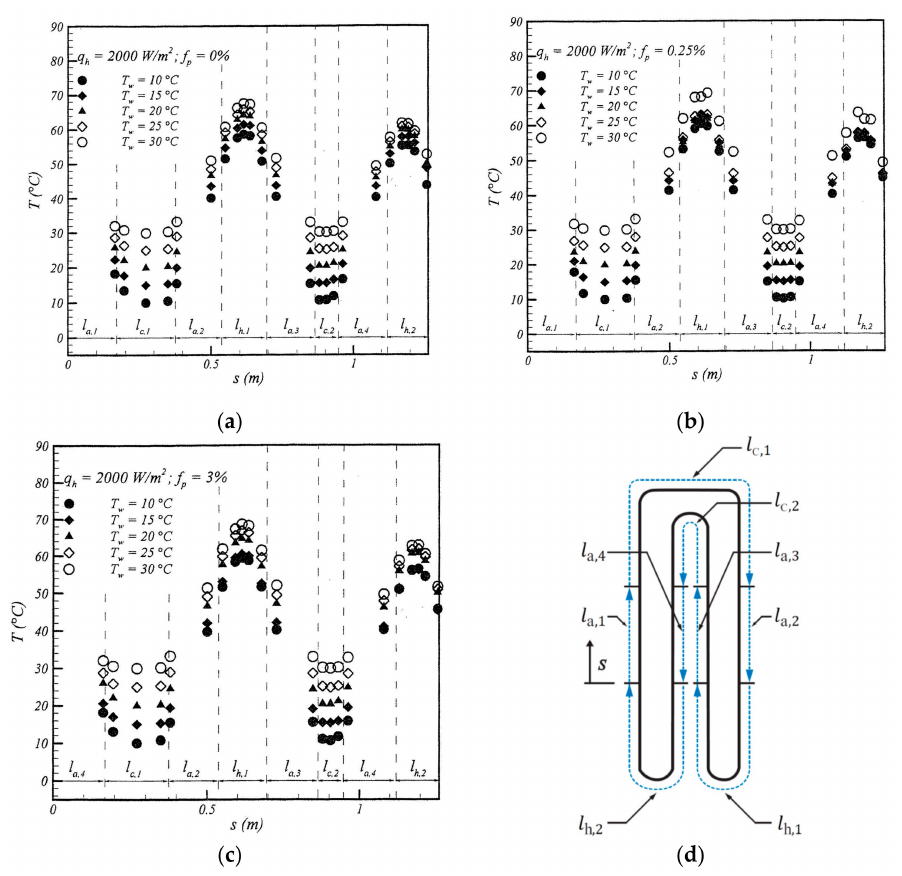
Figure 7. Steady-state temperature distributions of the fluid under different T w value ( q h = 2000 W/m 2 ): ( a ) f p = 0%; ( b ) f p = 0.25%; ( c ) f p = 3%; ( d ) The experimental